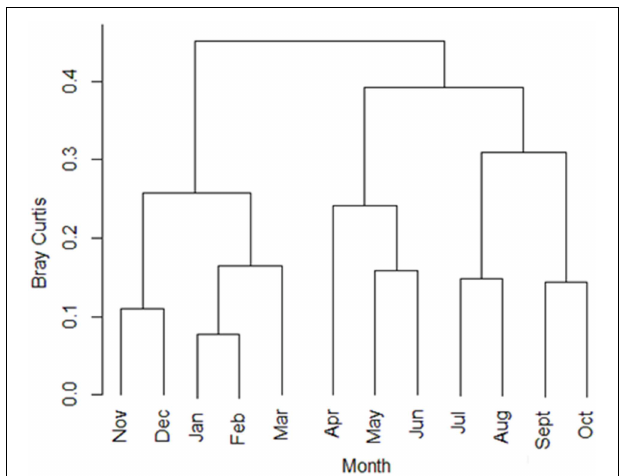
FIGURE 7 | Cluster analysis of spawning months over which Brazilian marine fishes reproduce (based on Bray-Curtis similarity matrix).